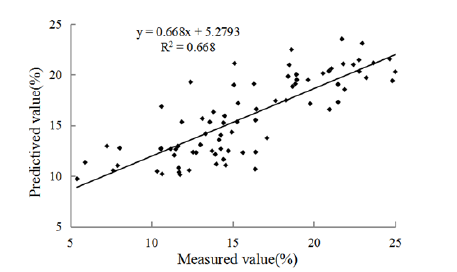
Figure 6. Estimated result of PLSR